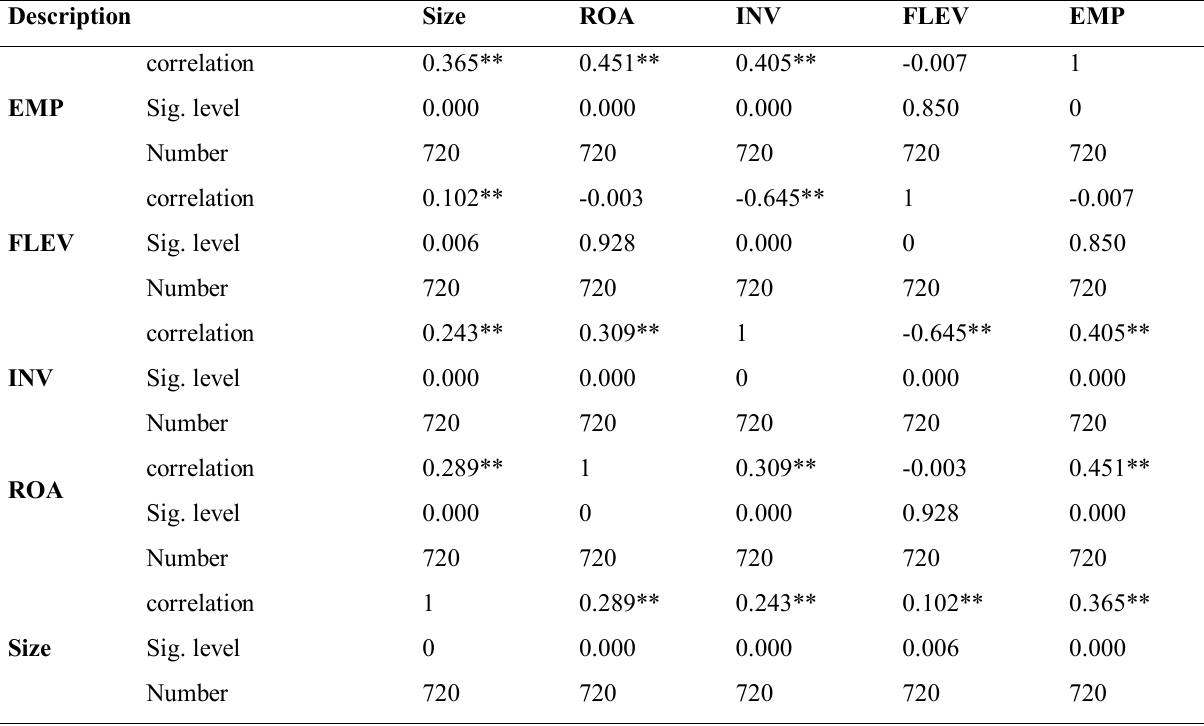
Table 4 – Pearson